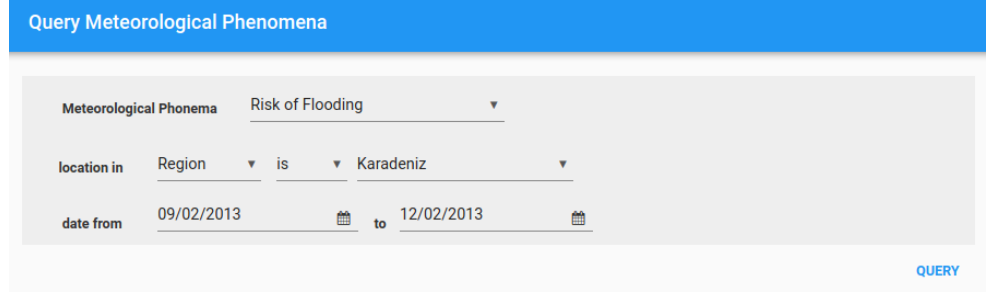
Figure 6. Meteorological phenomena query